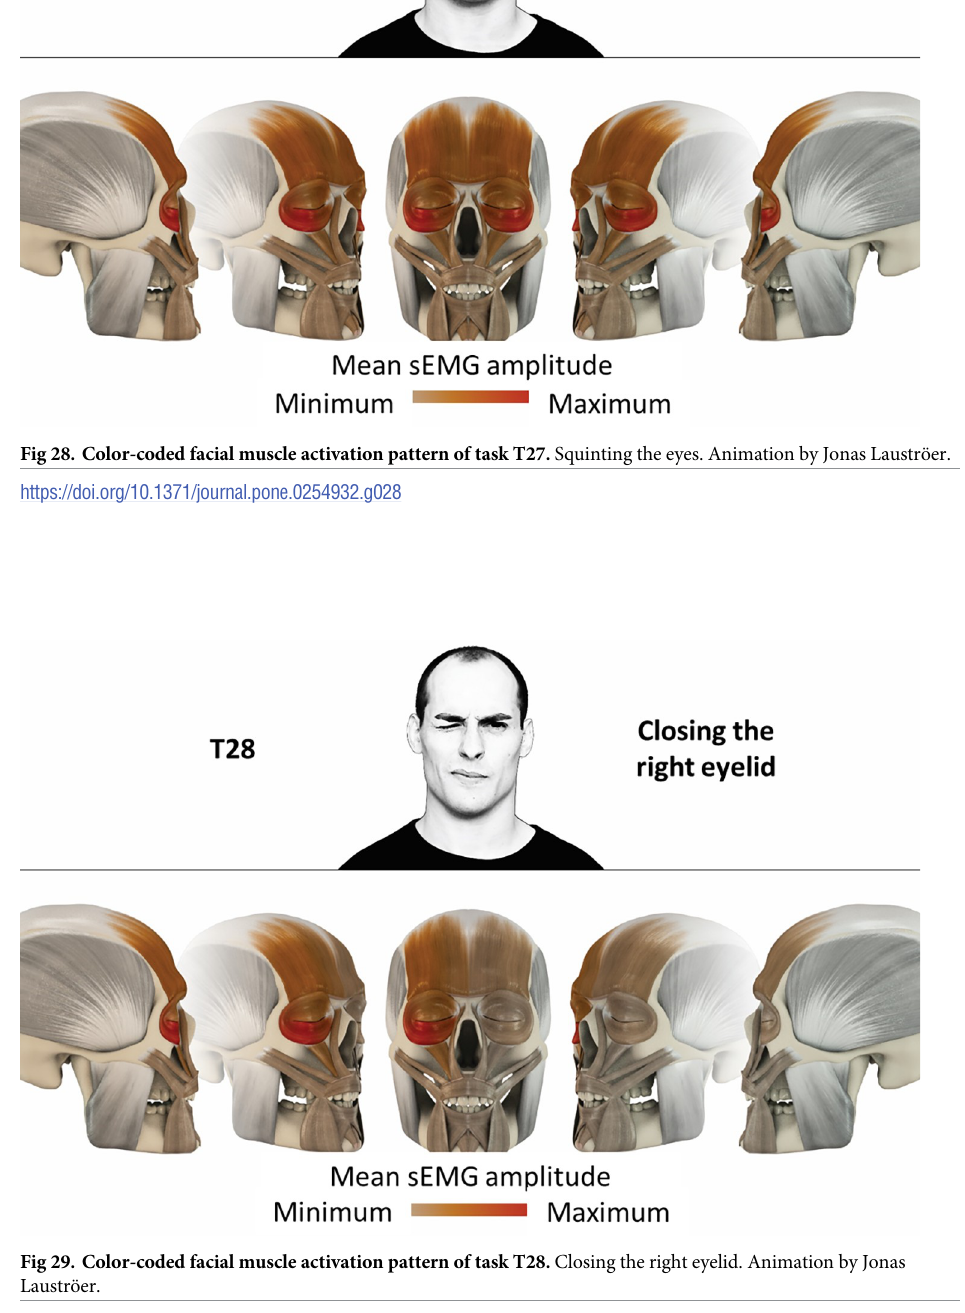
PLOS ONE | https://doi.org/10.1371/journal.pone.0254932 July 19,